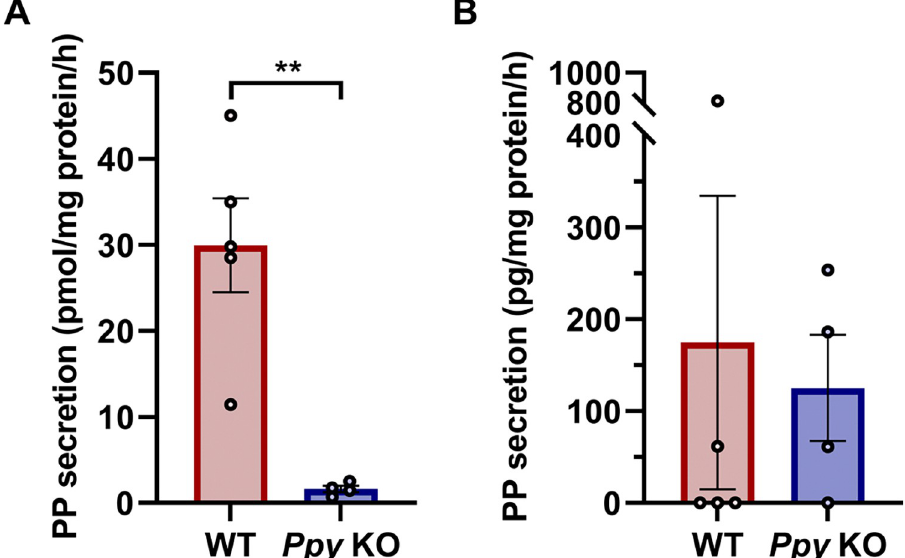
Fig 3. Evaluation of the accuracy of the two PP ELISA systems. (A) PP secretion from islets in the head region of the pancreas of 10-week-old WT mice (n = 5) and Ppy -KO mice (n = 4) measured by our PP ELISA system established in this study. (B) PP secretion from islets in the head region of the pancreas of 10-week-old WT mice (n = 5) and Ppy -KO mice (n = 4) measured using a commercially available kit. Values were normalized by the amount of protein in WT or Ppy -KO islets from the head region of the pancreas. Data are shown as the mean ± SEM, and analyzed by the two- tailed unpaired t -test. �� p < 0.01.